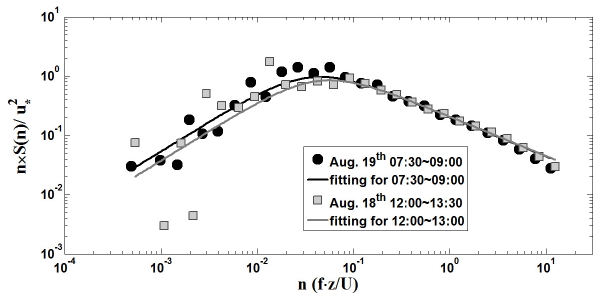
Fig. 5. Power spectra of the u -component wind obtained un- der slightly unstable conditions (black circles; 07:30 ∼ 09:00 of 19 August) and in fully developed boundary layer (gray squares; 12:00 ∼ 13:30 of 18 August). Black and gray solid lines represent fitting curves for slightly unstable air and CBL,